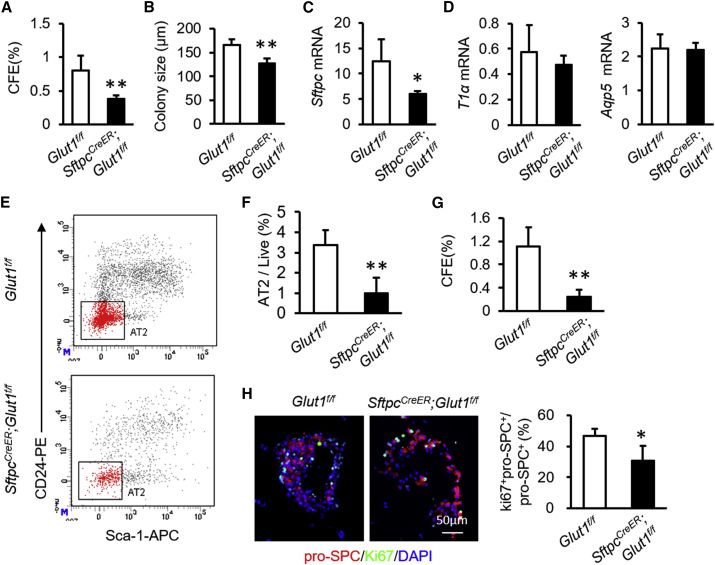
Genetic Deletion of Glut1 Inhibits AT2 Cell Proliferation(A) CFEs of AT2 cells isolated from Atg5f/f or SftpcCreER;Glut1f/f mice at steady state (n = 5).(B) Colony sizes of organoid cultures of AT2 cells isolated from Atg5f/f or SftpcCreER;Glut1f/f mice (n = 5).(C) Sftpc mRNA expression in organoid cultures (n = 5).(D) T1α and Aqp5 mRNA expression in organoid cultures (n = 5).(E and F) Representative charts of flow cytometric analysis (E) and summarized abundance (F) of AT2 cells in SftpcCreER;Glut1f/f mice after BLM treatment relative to littermate controls (n = 5).(G) CFEs of AT2 cells isolated from Atg5f/f or SftpcCreER;Glut1f/f mice after BLM treatment (n = 5).(H) Immunostaining of organoid cultures and quantification of Ki67+pro-SPC+ cells as a proportion of total pro-SPC+ cells in organoid cultures from Atg5f/f or SftpcCreER;Glut1f/f mice after BLM treatment (n = 5). Data are representative of three independent experiments with error bars representing the mean ± SD. ∗p < 0.05, ∗∗p < 0.01.